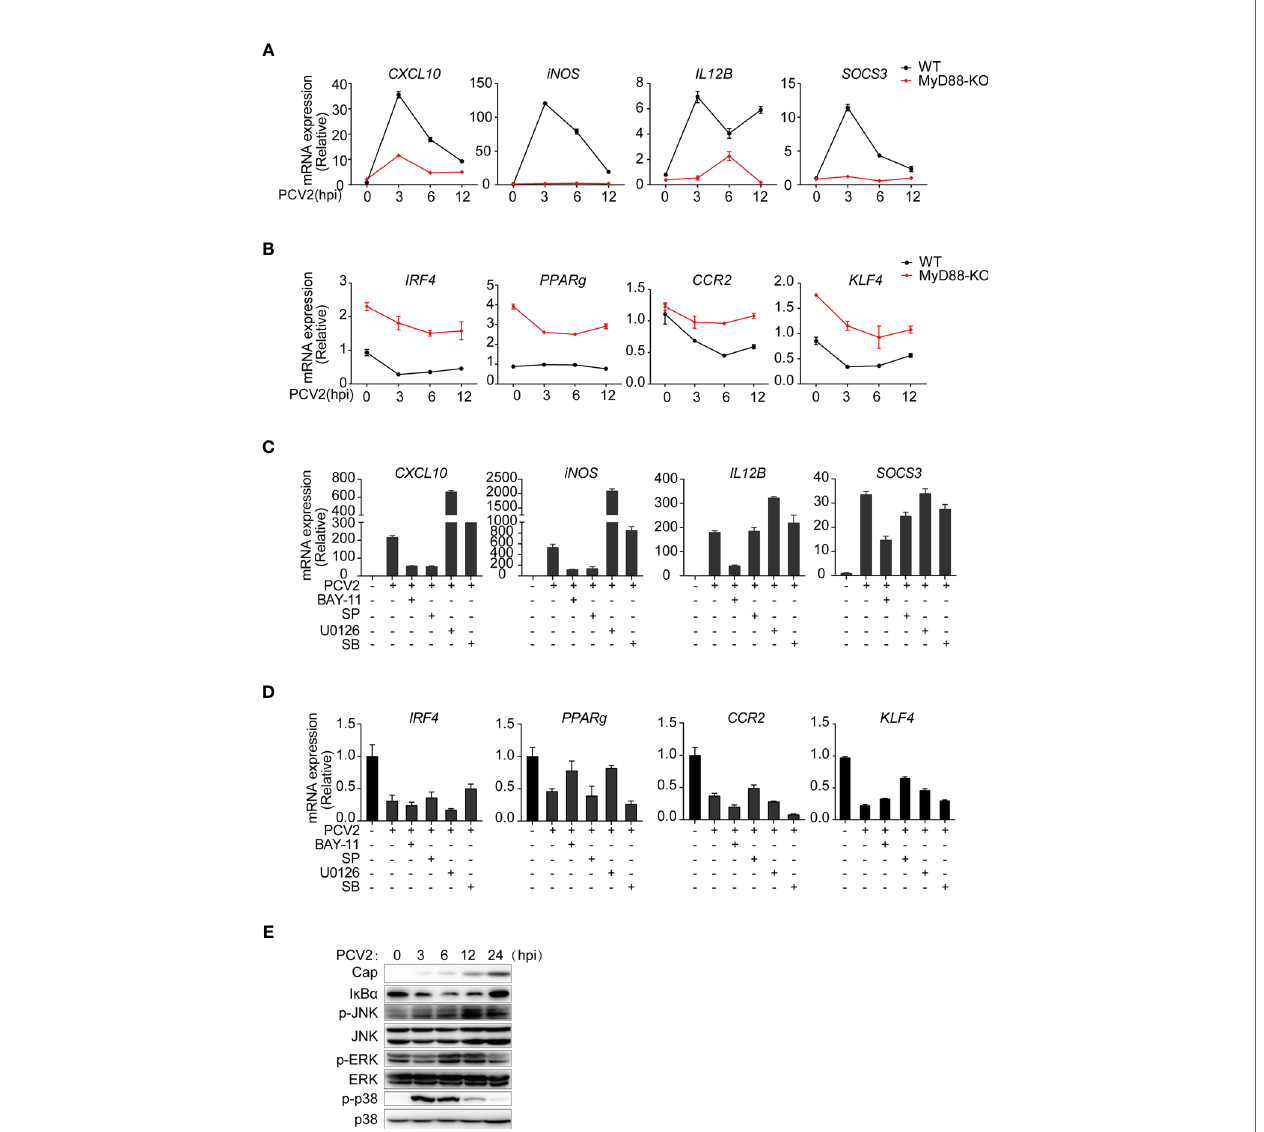
FIGURE 3 | PCV2 regulates M1-polarized macrophages via activation of NF- k B and JNK signals. (A, B) qPCR analysis of mRNA expression of key M1-associated genes (A) or M2-associated genes (B) in BMDMs obtained from wild-type and MyD88 -de fi cient infected with PCV2 (MOI=0.02, the same dose below) for indicated periods (horizontal axes). (C, D) qPCR analysis of mRNA expression of key M1-associated genes (C) or M2-associated genes (D) in BMDMs. Cells were left untreated or infected with PCV2 alone for 6 h, or pretreated with NF- k B inhibitor (BAY11-7082,10 m M), JNK inhibitor (SP600125,10 m M), ERK inhibitor (U0126,10 m M) or p38 inhibitor (SB203580, 10 m M) for 1 h followed by PCV2 infection for 6 h. (E) Immunoblot analysis of total NF- k B inhibitor I k B a and phosphorylated (p-) and total ERK, JNK and p38, in whole-cell lysates of BMDMs infected with PCV2 for various times (above lanes). Data are representative of two ( A – E ; mean + SD of technical triplicates in A – D ) independent